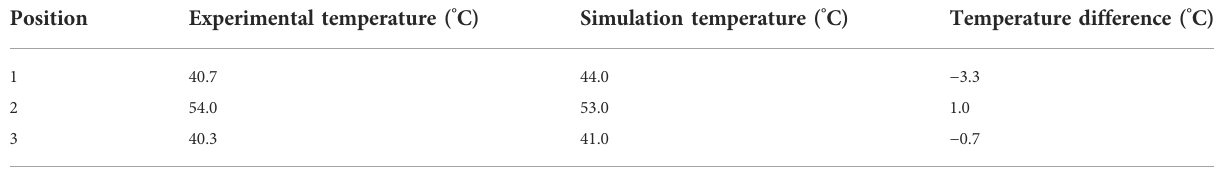
TABLE 8 Temperature comparison between experiment and simulation without slotted layer at different positions.